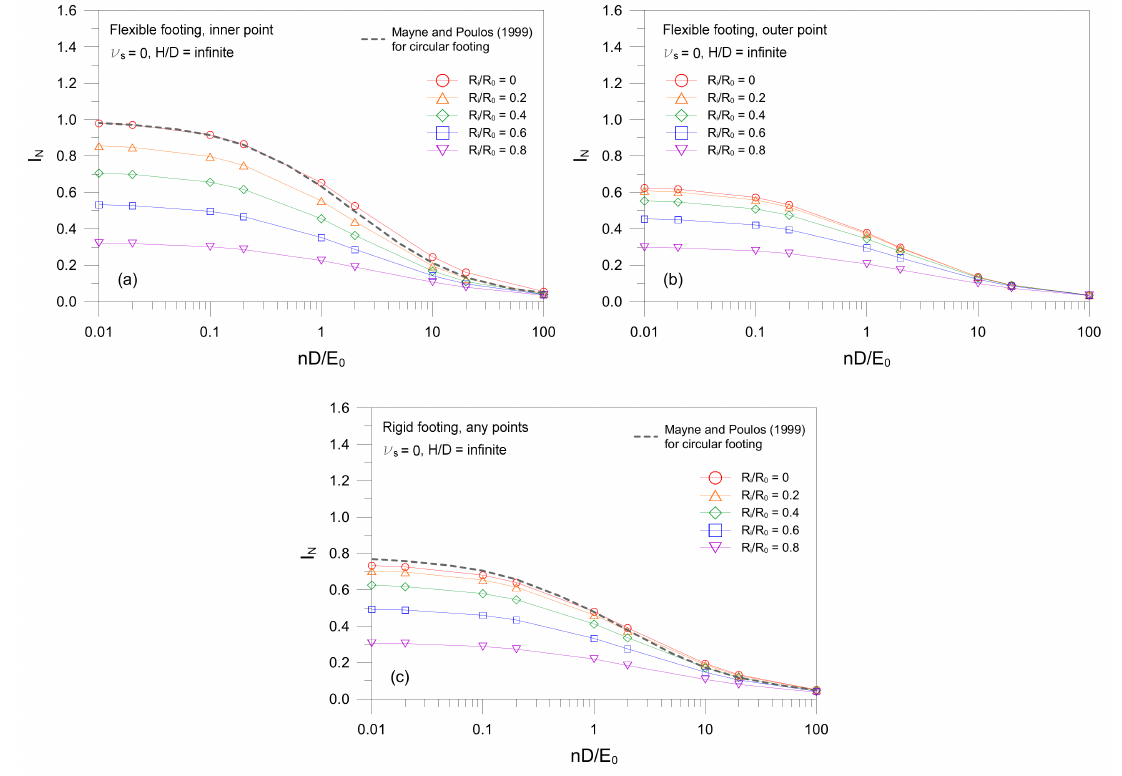
Figure 7. Variation of I N with nD / E 0 for flexible and rigid ring footings on inhomogeneous infinite soil: ( a ) flexible footing of inner point; ( b ) flexible footing of outer point; ( c ) rigid